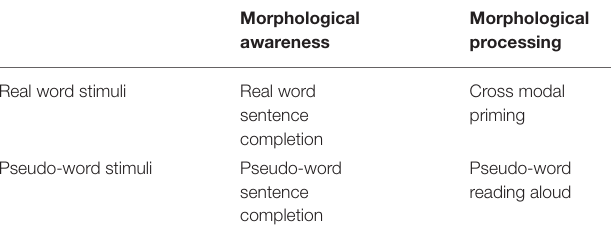
TABLE 2 | Theoretical mapping of morphological